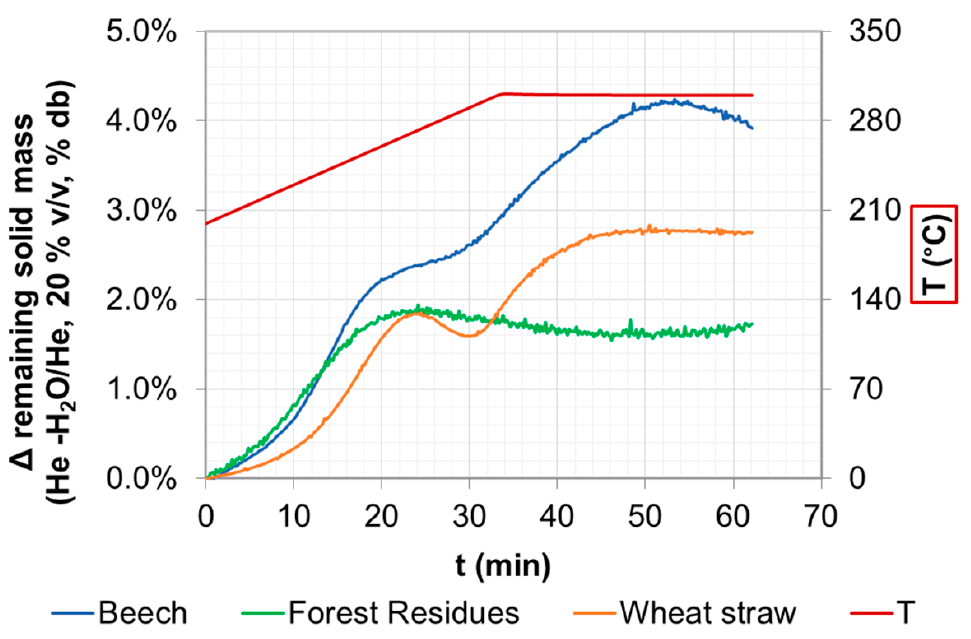
Figure 5. Instantaneous difference in remaining solid mass versus time and temperature from TGA results of the torrefaction of beech, forest residues and wheat straw under dry (He, 100% v/v ) and moist (H 2 O/He, 20% v/v ) atmospheres.